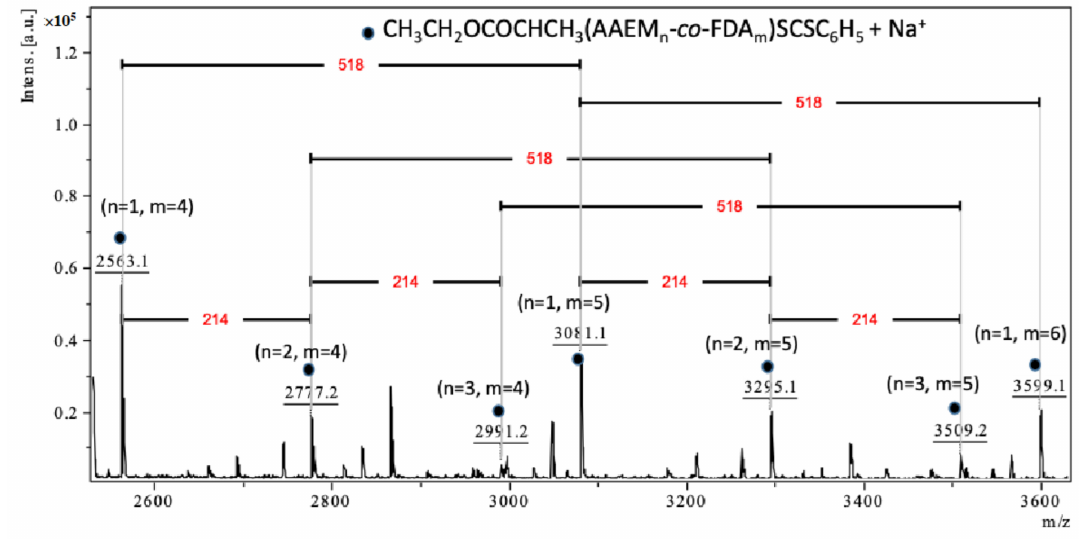
Figure 8. Enlarged MALDI-TOF-MS mass spectrum in positive ion mode of P(AAEM- co -FDA) (zoom between 2500 and 3610 m / z